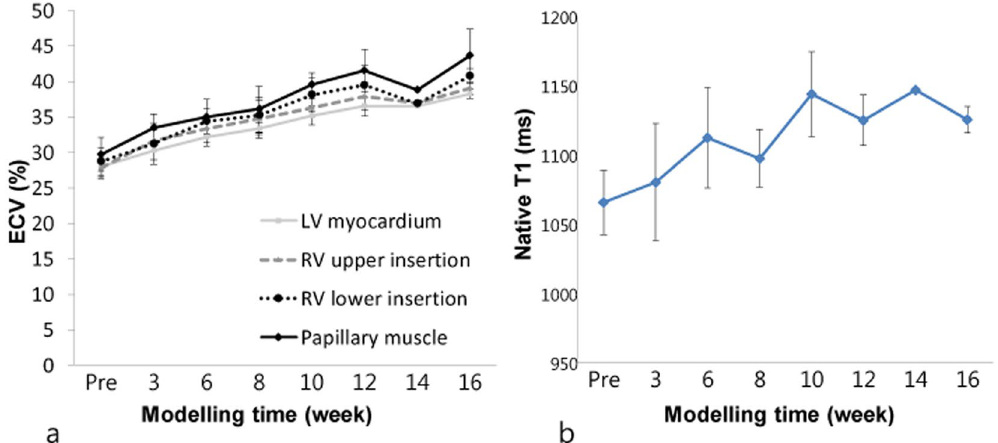
T1 mapping CMR data. The ECV and native T1 values changed as the modelling period increased. The mean ECV values of the mid-LV increased relative to those of the baseline group and significantly increased beginning at week 3 ( p = 0.002; Table 2, Fig. 2a). Compared with the LV myocardium, the ECV values of the right ventricle (RV) upper/lower insertion sites and papillary muscle were higher than those of the LV myocardium. The mean native T1 values in the mid-LV also increased according to the modelling time. The native T1 value of the 6-week model differed significantly from the baseline ( p < 0.001; Table 2 and Fig. 2b). The inter-observer agreements were good, with intra-class correlation coefficients (ICCs) (95% confidence interval [CI]) of 0.951 (0.919–0.971) for native T1 values, 0.958 (0.929–0.976) for the ECV of the LV myocardium, 0.915 (0.821–0.959) for the ECV of the RV upper insertion, 0.919 (0.830–0.961) for the ECV of the RV lower insertion, and 0.920 (0.832–0.962) for the ECV of the papillary muscle.